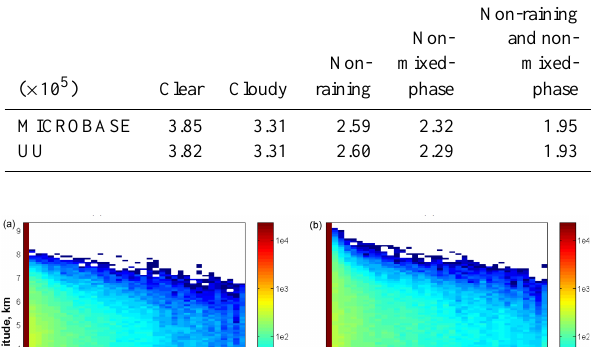
Table 1. Cloud occurrence at the SGP site based on the 5-min res- olution MICROBASE and UU retrievals from 1998 to 2006. A ver- tical column is considered to be cloudy when it contains at least one cloudy layer. A cloudy column is non-raining/non-mixed-phase when it contains no raining/mixed-phase layer.